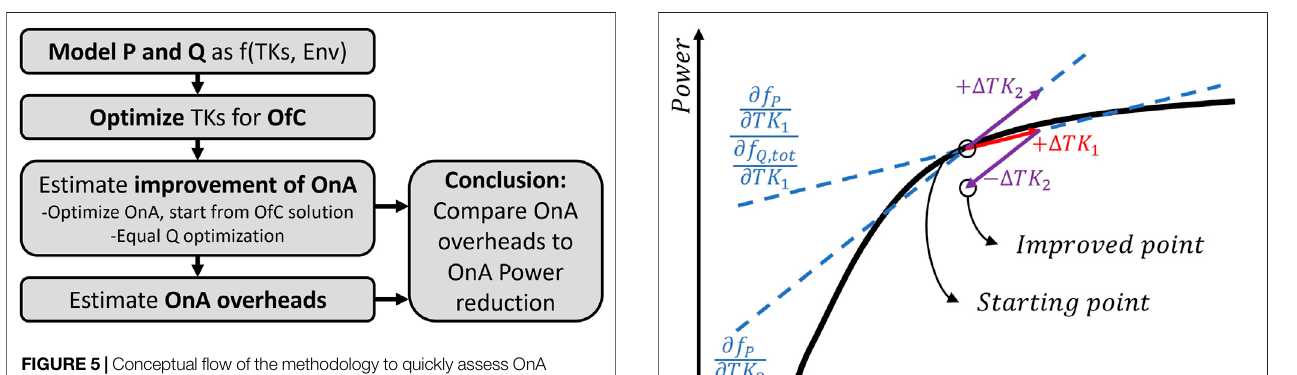
FIGURE 5 | Conceptual fl ow of the methodology to quickly assess OnA feasibility.